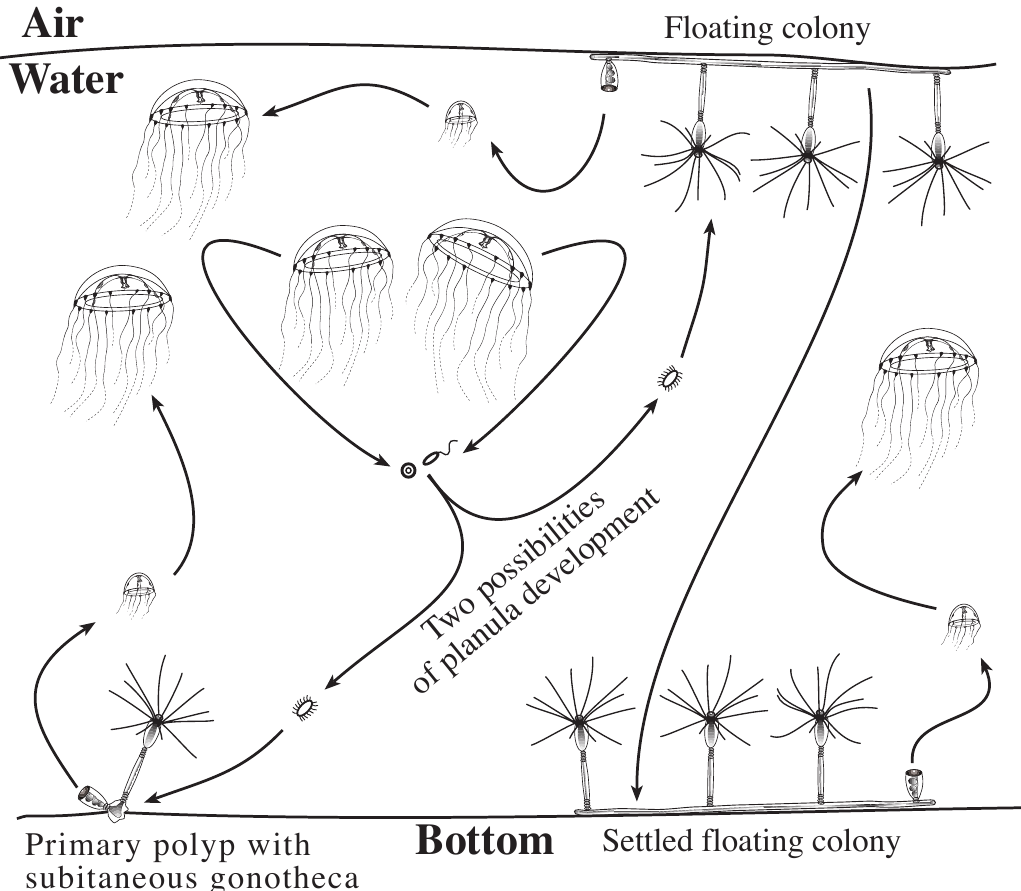
Bottom Settled floating